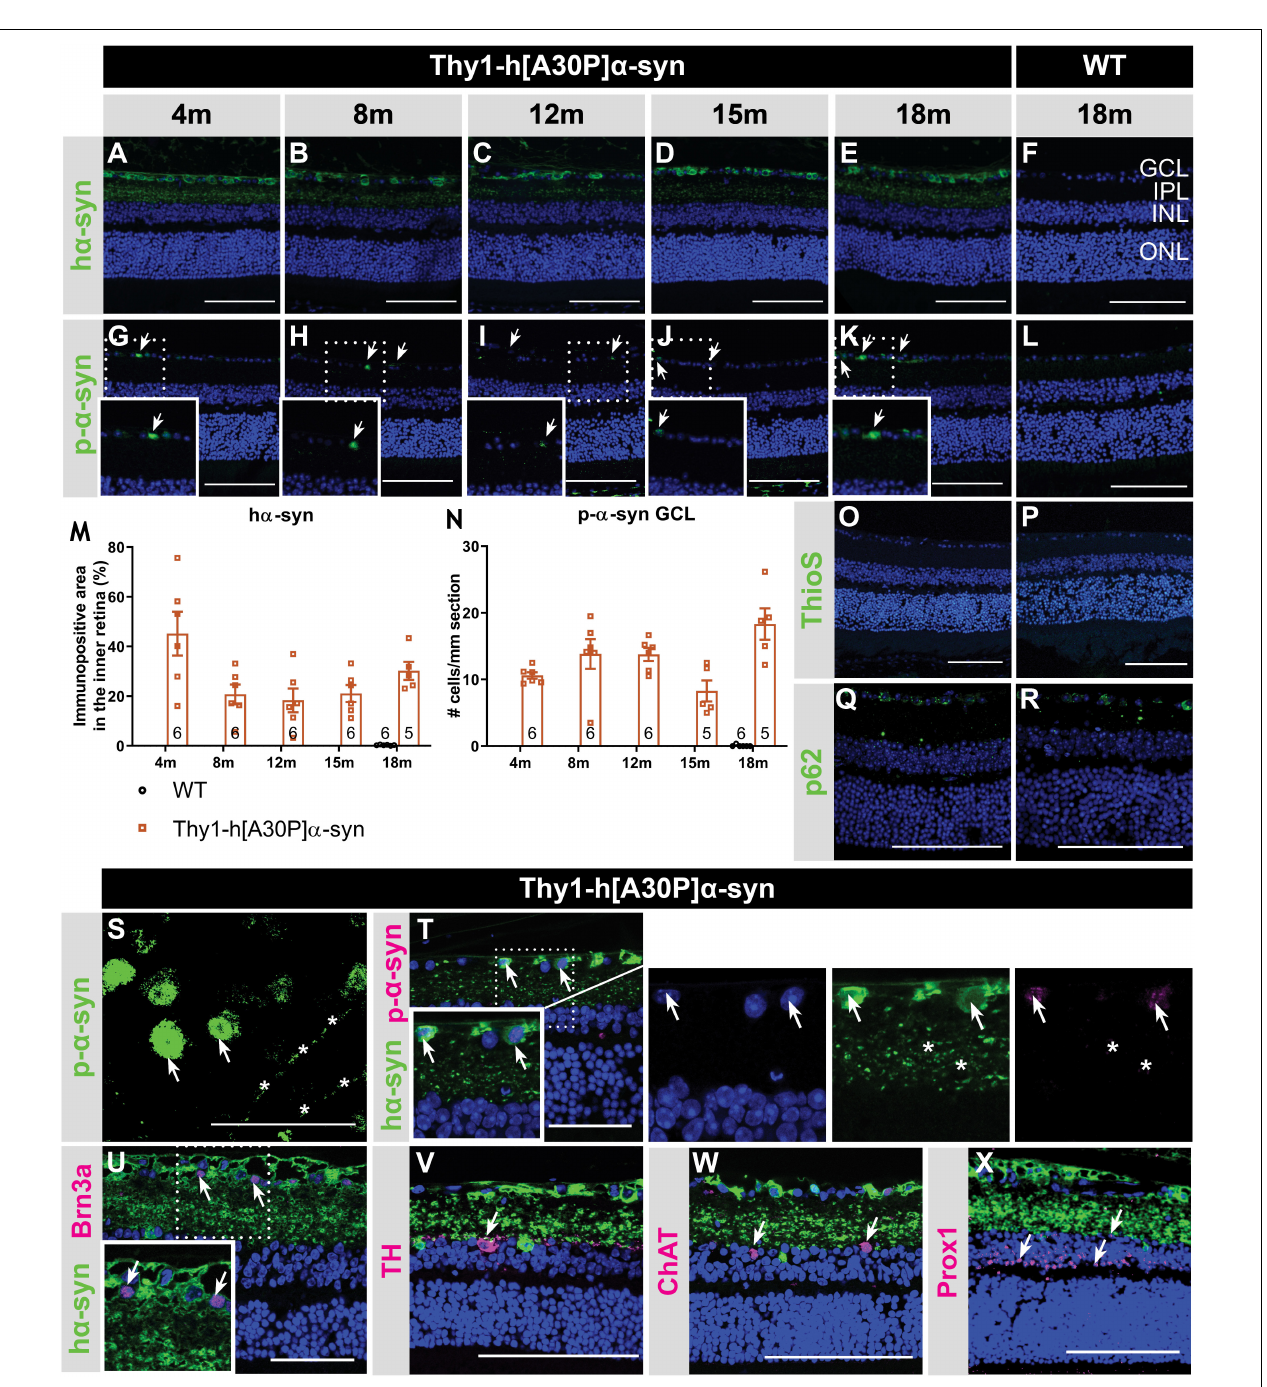
FIGURE 1 | Inner retinal h α -syn expression is accompanied by α -syn phosphorylation, yet no ThioS positive aggregation or p62 accumulation, in the retina of Thy1-h[A30P] α -syn mice. Representative images of h α -syn immunostainings (A–E) ; p- α -syn immunostainings (G–K) ; and ThioS staining (O) on retinal sections of α -syn mice at 4, 8, 12, 15 and 18 months of age. (F,L,P) No staining was observed in the WT controls, at any age (only 18 months shown here). (M,N) Quantitative analysis of the h α -syn fluorescent area and counting of the p- α -syn positive cells did not reveal an increase of h α -syn expression in the inner retina or p- α -syn cell density in α -syn mice with age. (O,P) No ThioS positive inclusions were found in the retina of transgenic nor wild type animals in any of the age groups. (Q,R) No difference in retinal p62 accumulation or localization was detected between transgenic and wild type animals at 18 months of age. (S) p- α -syn immunostaining on a retinal wholemount of an α -syn mouse showed p- α -syn localization in cell bodies (arrows) and neurites (asterisks). (T) Double staining of h α -syn with p- α -syn revealed clear colocalization. (U–X) Double staining of h α -syn with Brn3a, TH, ChAT and Prox1 revealed expression of Brn3a in h α -syn positive cells, yet no colocalization in dopaminergic and cholinergic cells. Scale bar: 100 µ m (A–R, V–X) or 50 µ m (S–U) ; GCL, ganglion cell layer; INL, inner nuclear layer; IPL, inner plexiform layer; and ONL, outer nuclear layer.